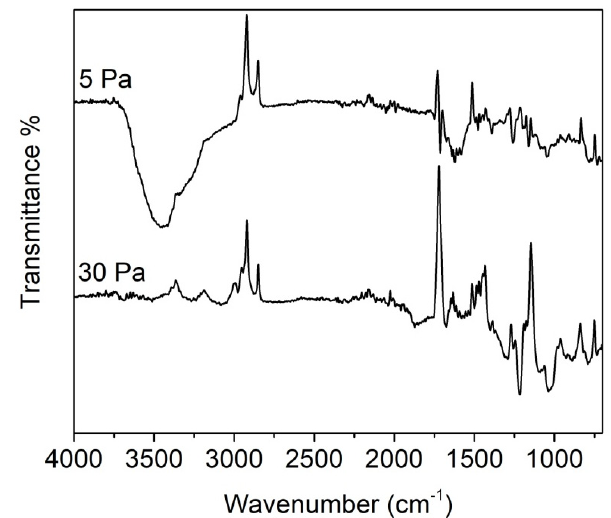
Figure 2. Attenuated Total Reflectance Fourier Transform Infrared (ATR / FTIR)spectra of PMMA IOLs treated at different SF 6 pressures (peak power = 70 W, DC = 50%). Displayed spectra were obtained by subtracting the spectrum of the untreated PMMA to the spectra of the treated samples.